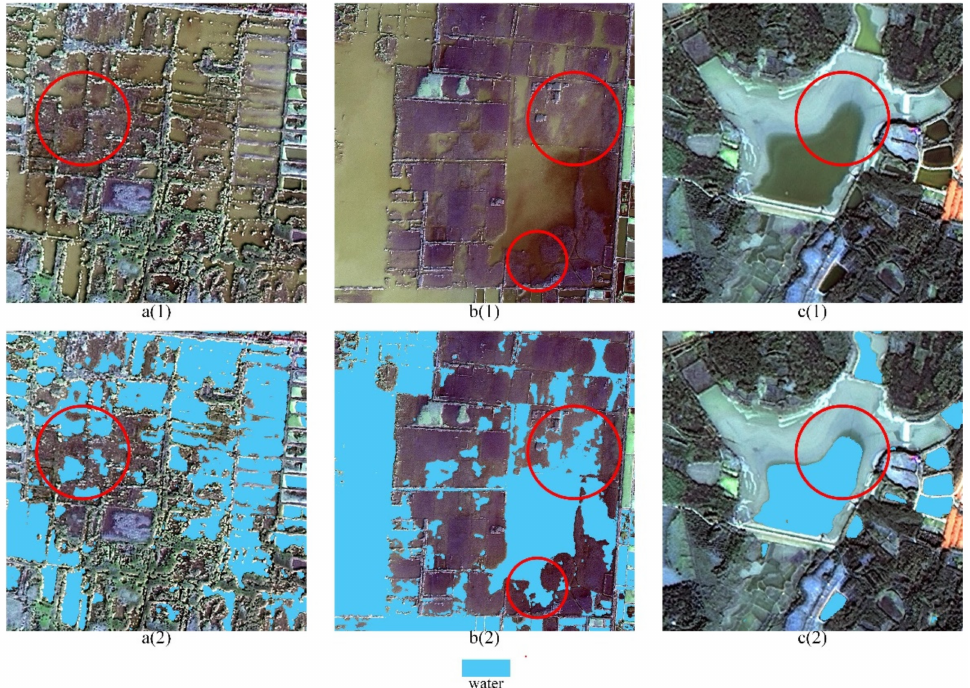
Figure 15. Border area of water and non-water and the water extraction results. ( a ( 1 ), b ( 1 )) and are the raw image of ponds mixed with vegetation and sediment; ( a ( 2 ), b ( 2 )) are the water areas extracted from ( a ( 1 ), b ( 1 )) using LMSWENet; ( c ( 1 ), c ( 2 )) are the raw image of wetland and the water extraction